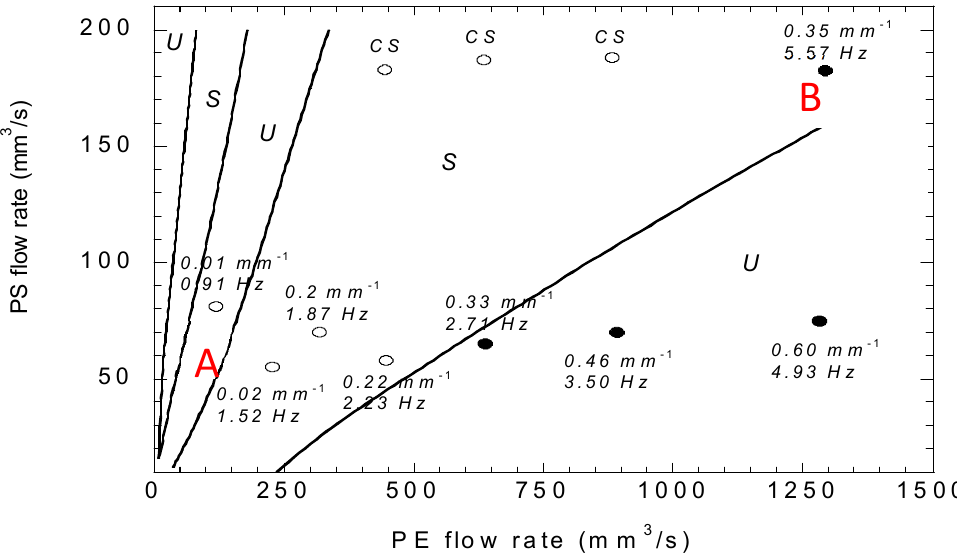
Figure 19. Stability of the coextrusion pressure flow of a polystyrene and a polyethylene at 200 °C; open symbols correspond to experimentally stable conditions and filled symbols are for experimental unstable conditions. Asymptotic stability calculations with a White-Metzner viscoelastic constitutive equation delimit the stable (S) and unstable (U) zones (Adapted from Ref. [32]). (b) Convective Stability Analysis